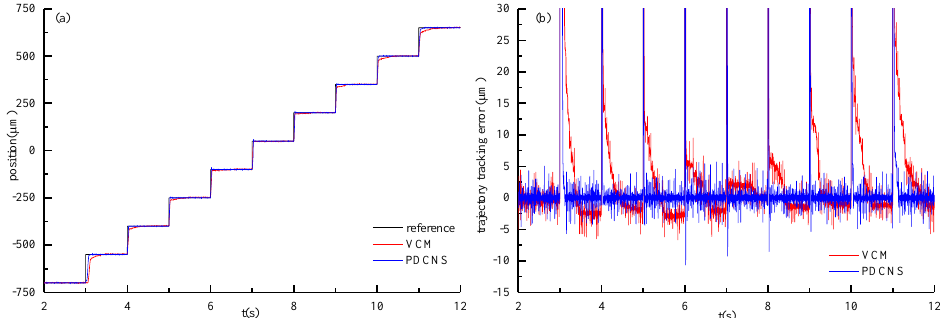
Figure 12. Consecutive-step trajectory (from − 0.7 mm to 0.65 mm with a step size of 0.15 mm) control tests ( a ) tracking results and ( b ) tracking errors.